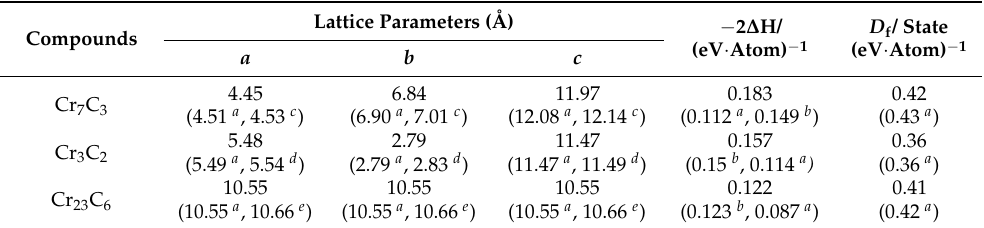
Table 1. Calculated parameters, formation enthalpy ( Δ H ), and DOS at the Fermi lever D f of Cr 7 C 3 , Cr 3 C 2 and Cr 23 C 6 at zero pressure.